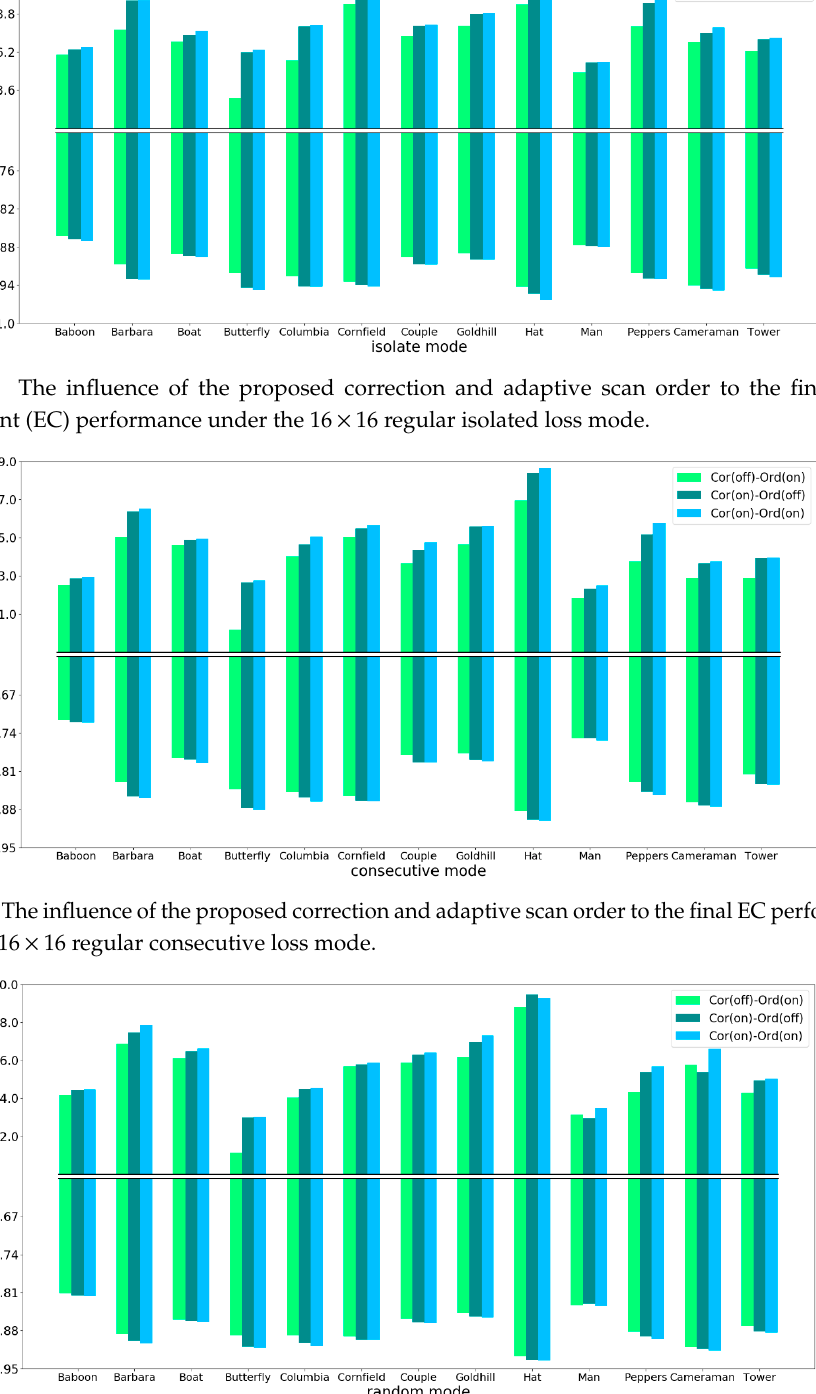
Figure 15. The influence of the proposed correction and adaptive scan order to the final EC performance under the 16 × 16 random loss mode.